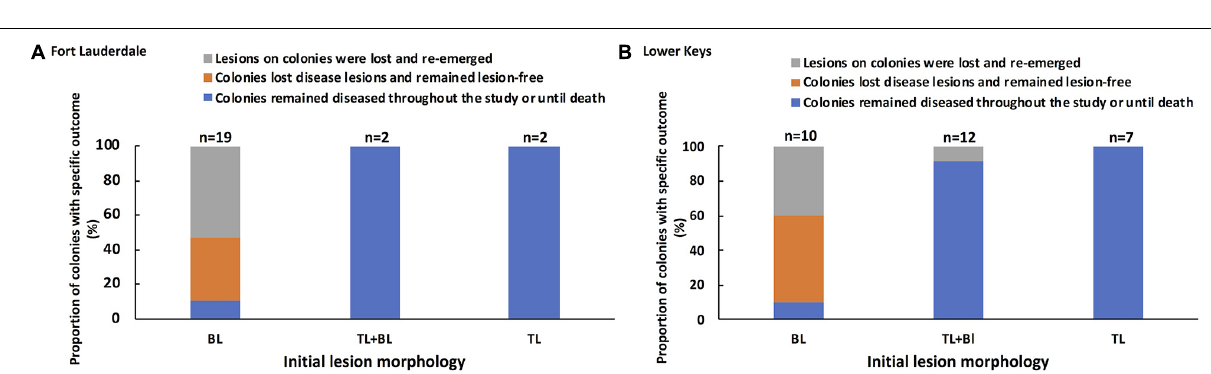
FIGURE 8 | Association between initial lesion morphology and subsequent disease outcome for tagged M. cavernosa at study sites in Fort Lauderdale (A) and in the Lower Keys (B) . Colonies at Fort Lauderdale were followed for a little over 2 years (Nov. 2018 – Jan. 2021) and two sets of colonies in the Lower Keys were each followed for a year. The Lower Keys year one tagged colonies were followed Nov. 2018 to Aug. 2019 and year two tagged colonies were followed Nov. 2019 to Dec. 2020. The number of colonies displaying each type of lesion is displayed above each